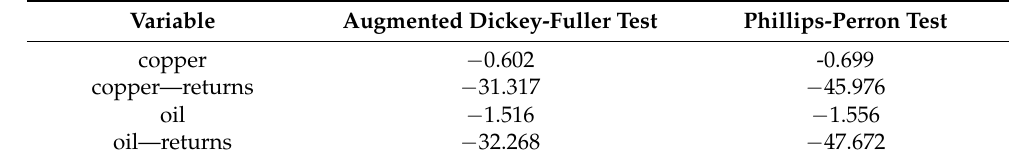
Table 5. Unit root tests.